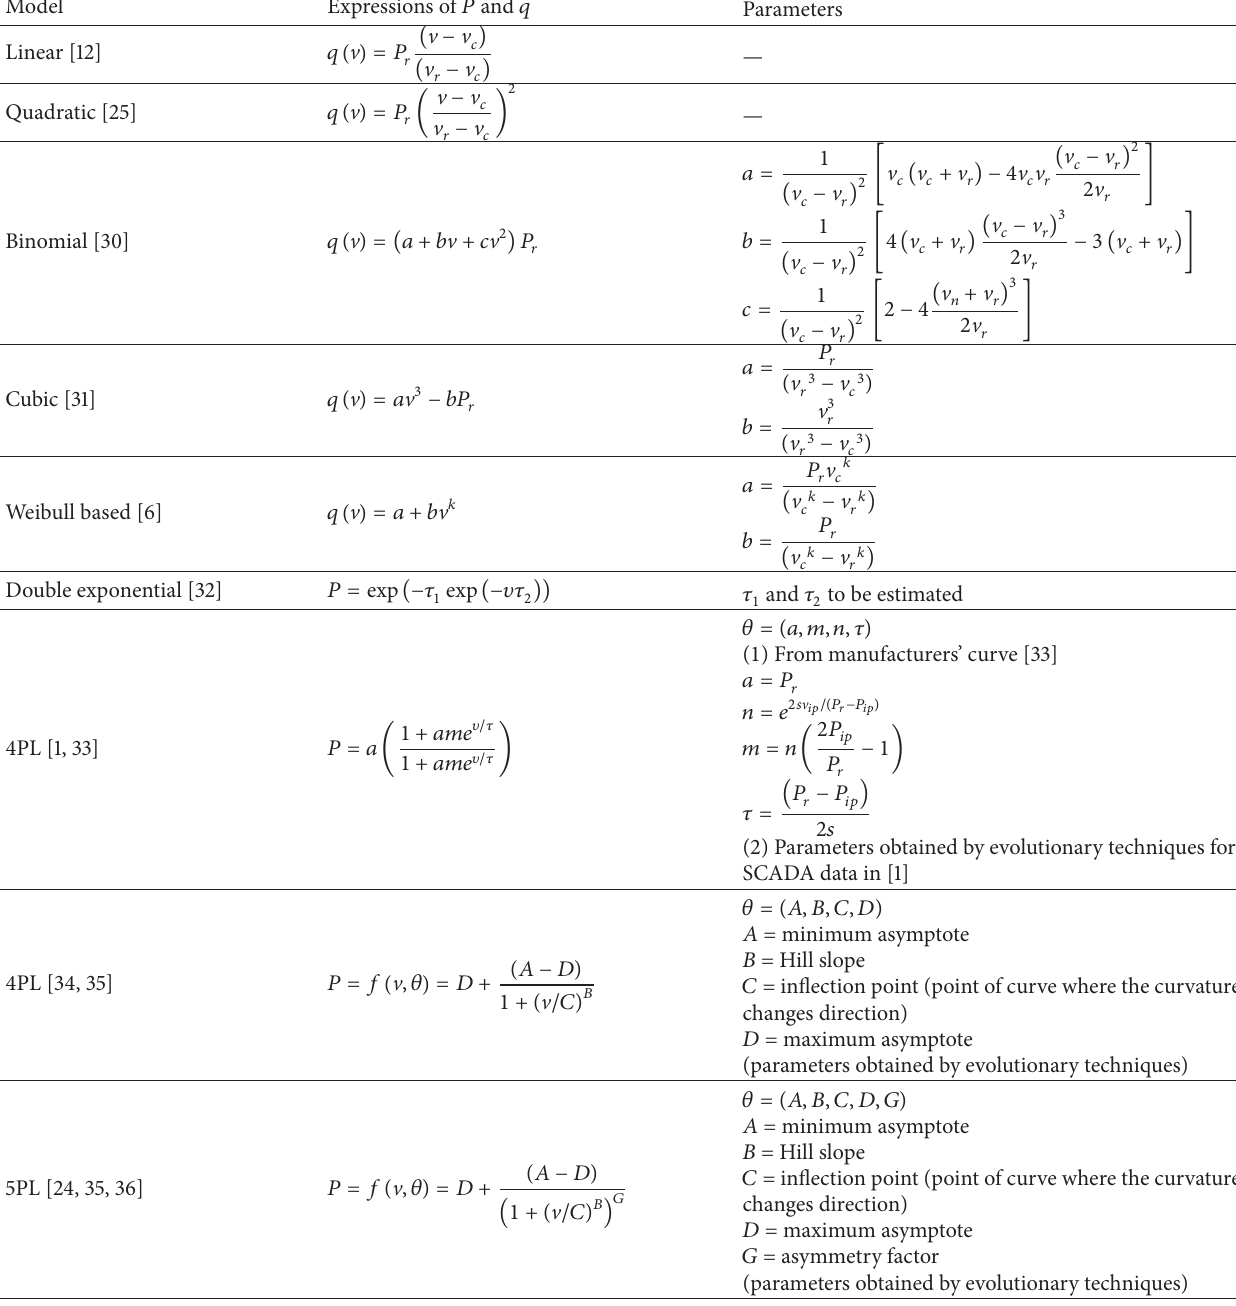
Table 1: Expressions of parametric